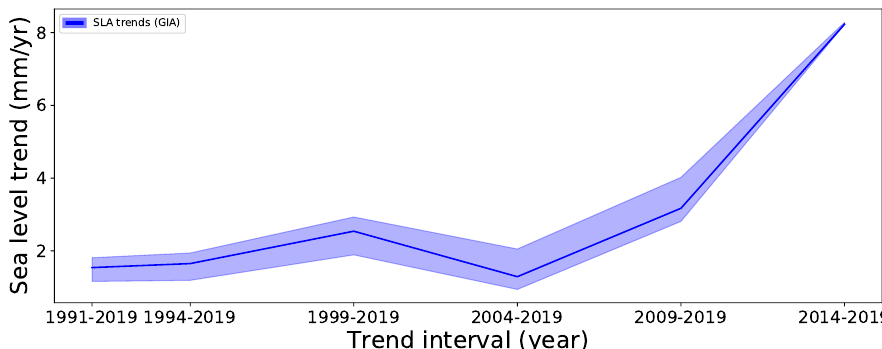
Figure 9. Sea level trends in the CCI DTU/TUM SLA period in steps of eliminating five years at a time. The light blue color shows the 95% confidence interval.